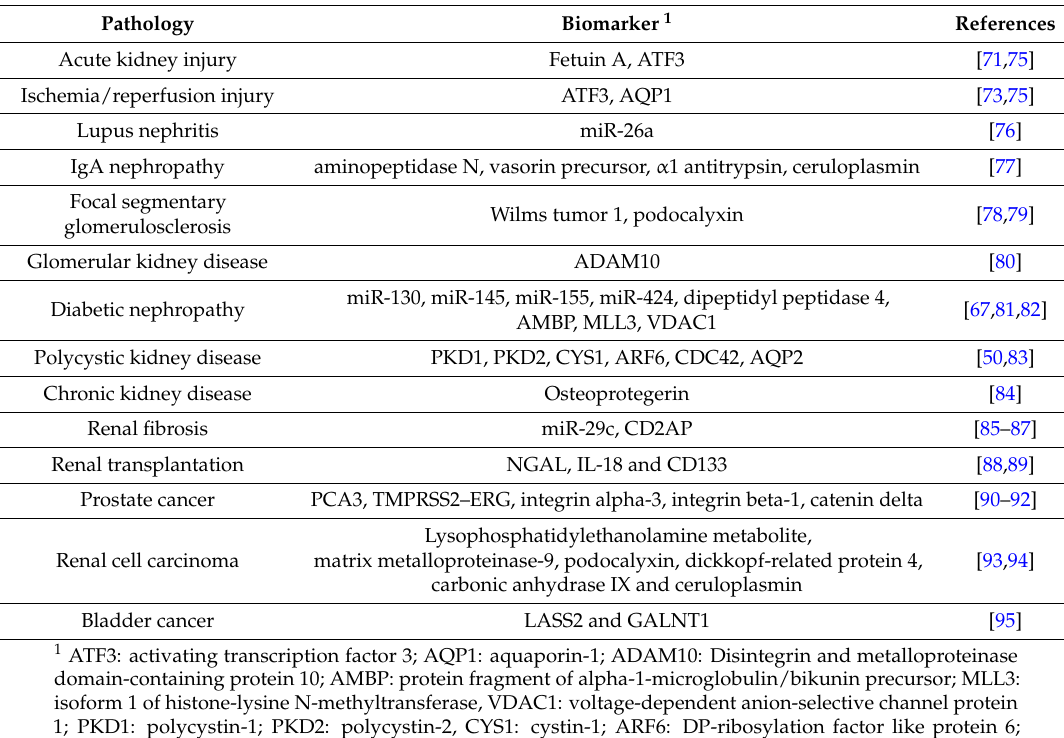
Table 2. Suggested or studied urinary EV biomarkers in different renal and urological